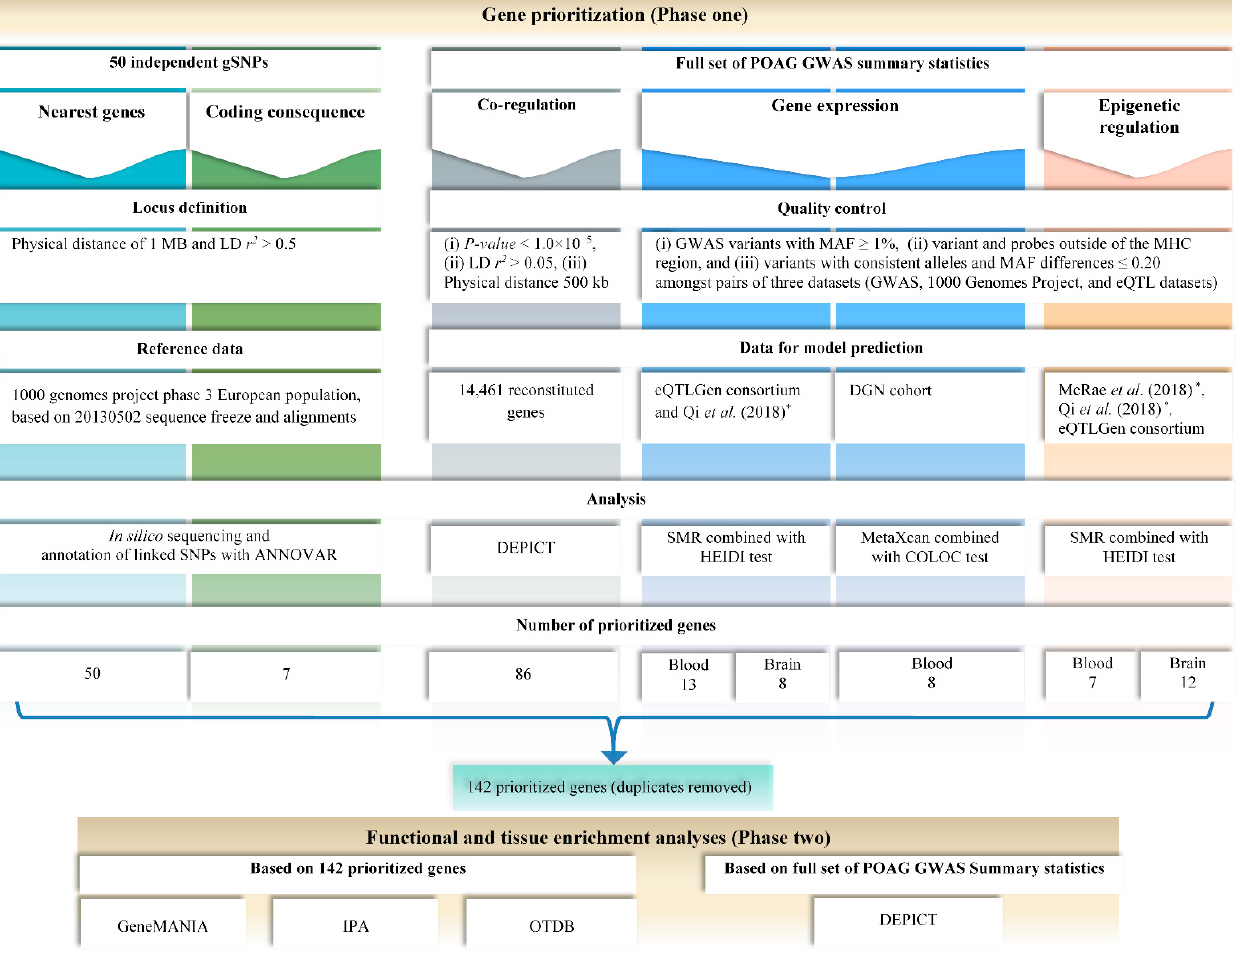
Figure 1. Summary of the analysis pipeline: phase one shows the gene prioritization pipeline which was performed based on (i) 50 independent gSNPs (via nearest genes and coding consequence) and (ii) the full set of POAG GWAS summary statistics, using co-regulation, gene expression, and epigenetic regulation approaches. It also presents a summary of the quality control thresholds, reference panel used, data used for model predictions, method of data analysis, and the final number of genes prioritized for each part separately and for the entire pipeline. Similarly, phase two summarizes the functional and tissue enrichment analyses, which were performed using the 142 prioritized genes and the full set of POAG GWAS summary statistics. * Qi et al. (2018) [31]; and McRae et al. (2018) [32].